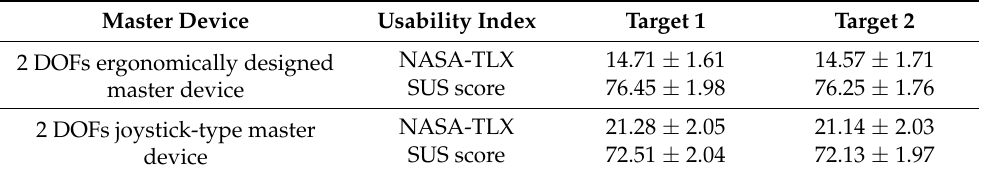
Table 3. Overall workload and system integration scores for pig right renal artery experiments (mean and standard